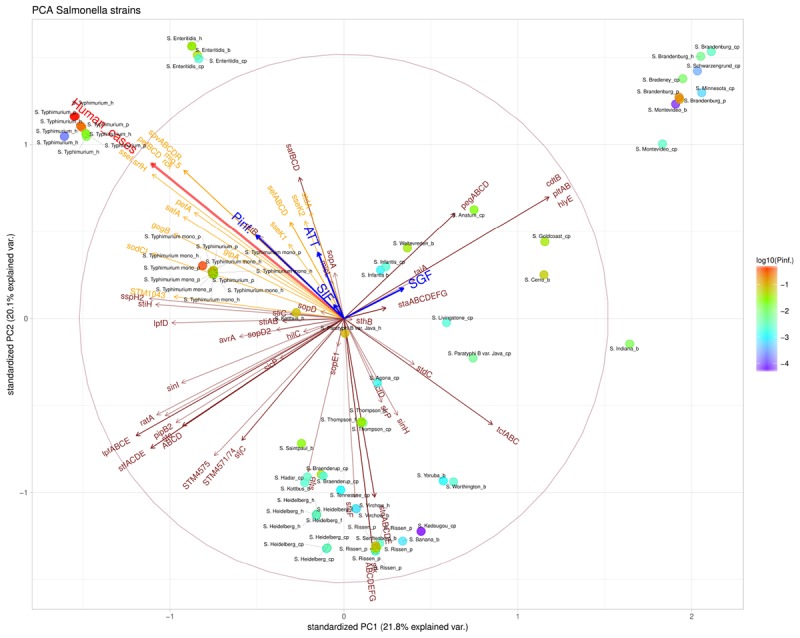
Principal component analysis (PCA) scatterplot calculated from the presence/absence of the various virulence genes (brown and orange arrows) in the Salmonella strains under investigation. The number of human cases (shown in red arrow) and survival up to the indicated stages SGF, SIF. ATT and INV [indicated as P(inf)] (shown in blue arrows). The color scale of the dots characterizes P(inf) of individual strains (indicated in the legend). Orange virulence genes are those associated with a positive P(inf) effect (p-value < 0.05) (see section “Genetic Variability Linked to in vitro Virulence,” Table 2). The length and direction of the variable arrows indicate how those variables contribute to the separation of the data when projected on the two components which explain the most data variance, i.e., PC1 and PC2. An arrow reaching the large circle means that it is fully projected on the two principal component plane. See Table 1 for additional strain information (b, broiler; cp, chicken product; f, food; h, human; p, pork). Strains of the same serovar and source have equal indicators (e.g., Typhimurium1_cp).